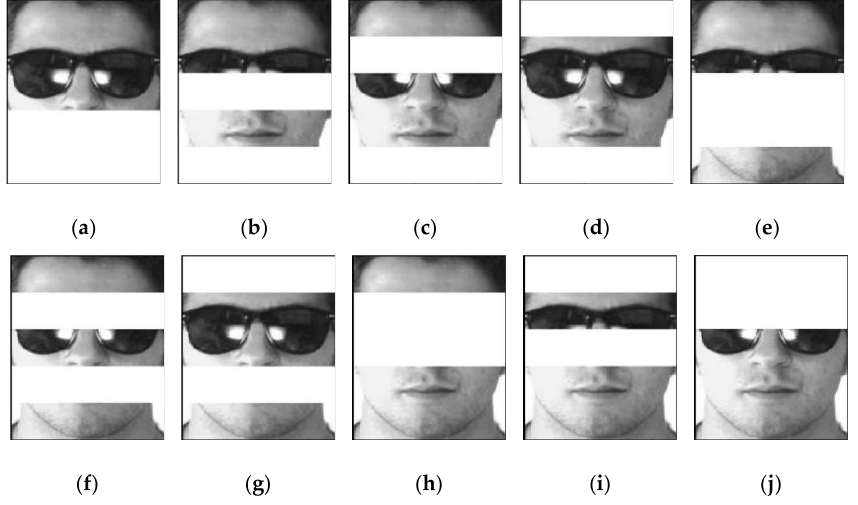
Figure 4. Arrangement and combination scheme of a certain test sub-image (involving sunglasses)